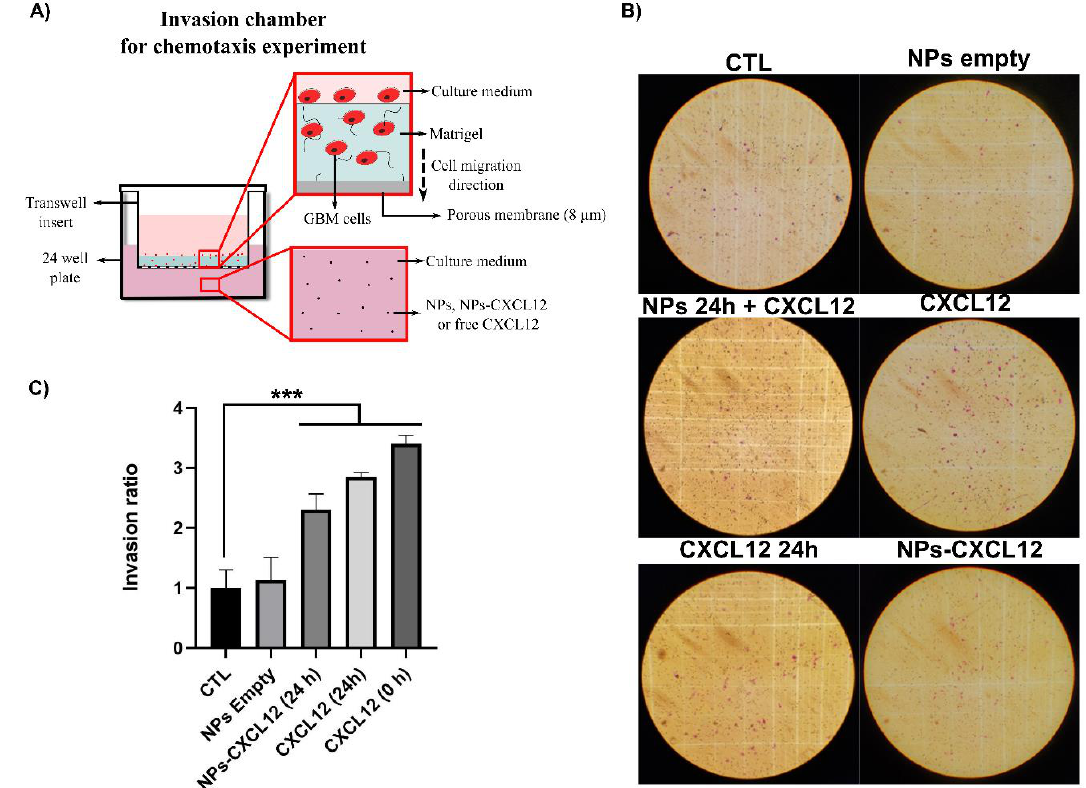
Figure 7. ( A ) Schematic of the invasion chambers used to perform chemotaxis assays. ( B ) Representative images of crystal violet stained F98 cells located at the porous membrane surface following 6 h of incubation for the following conditions: (1) DMEM 0.1% BSA (CTL); (2) empty NPs; (3) empty NPs